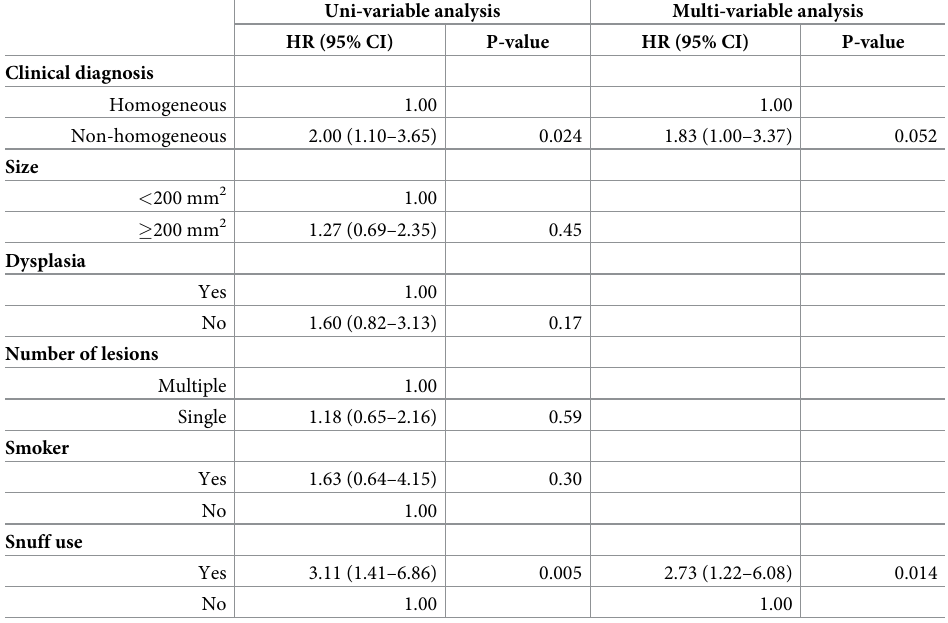
Table 3. Cox regression analysis of risk factors for the recurrence of